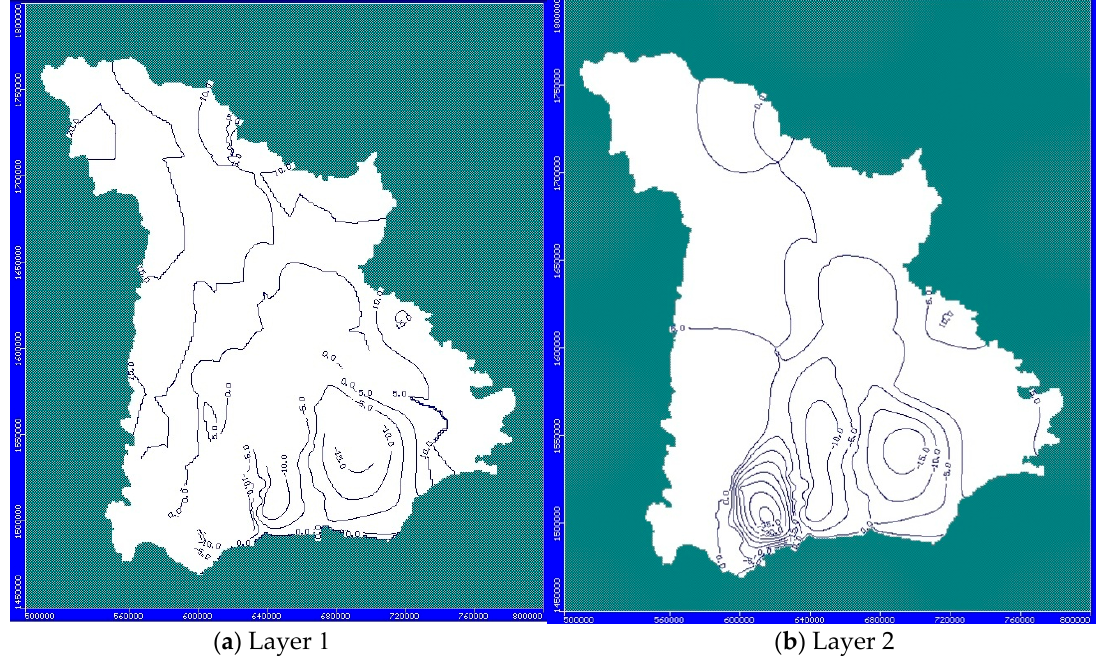
Figure 13. Equipotential line and flow direction results in the steady state: ( a ) Layer 1; ( b ) Layer 2.